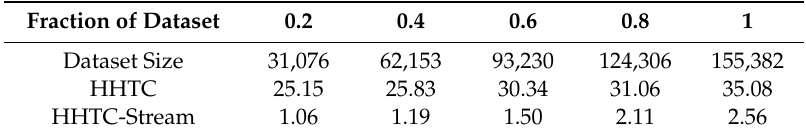
Table 8. Execution time (in seconds) with varying dataset sizes for both HHTC and HHTC-Stream to evaluate the scalability of our Hybrid Hashtags approach.